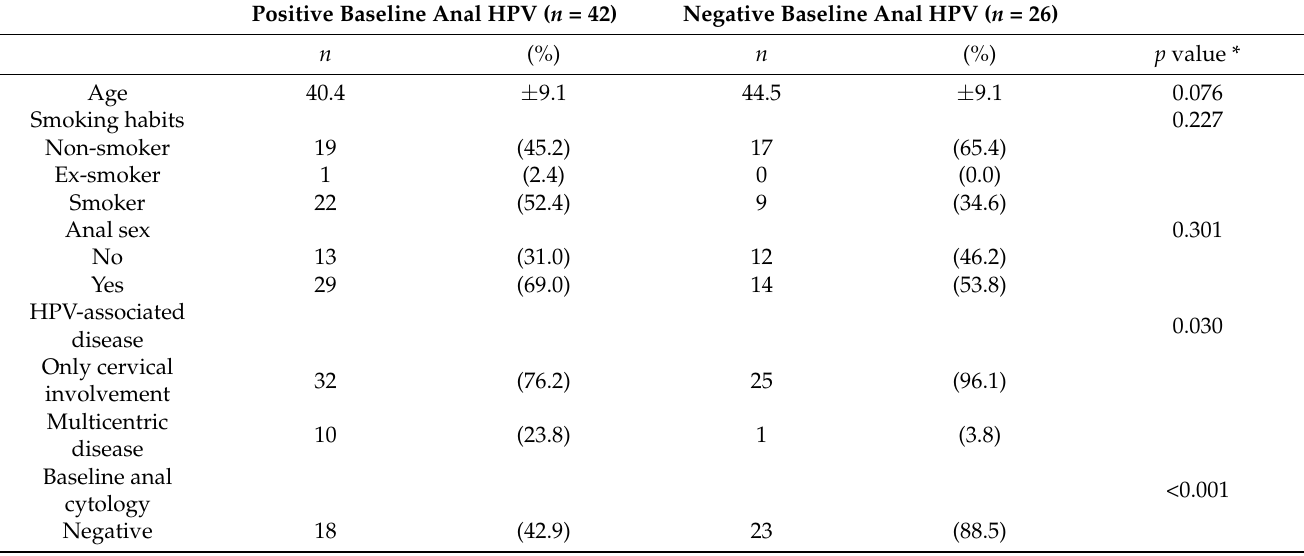
Table 1. Epidemiological characteristics at the baseline visit and pathological results of the women according to anal high-risk human papillomavirus (HPV) status at the first visit. Values are presented as mean ± standard deviation or absolute numbers and